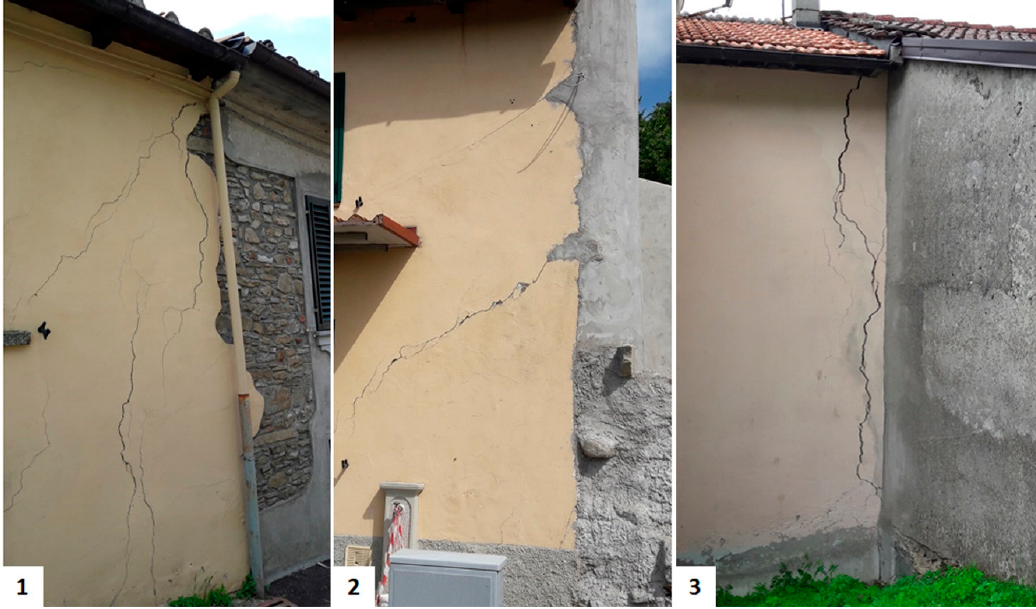
Figure 10. Cracks recognized during the field survey in the Carpineta hamlet. Landslide induced damage recognizable for the external walls (Photo 1, 2 and 3).